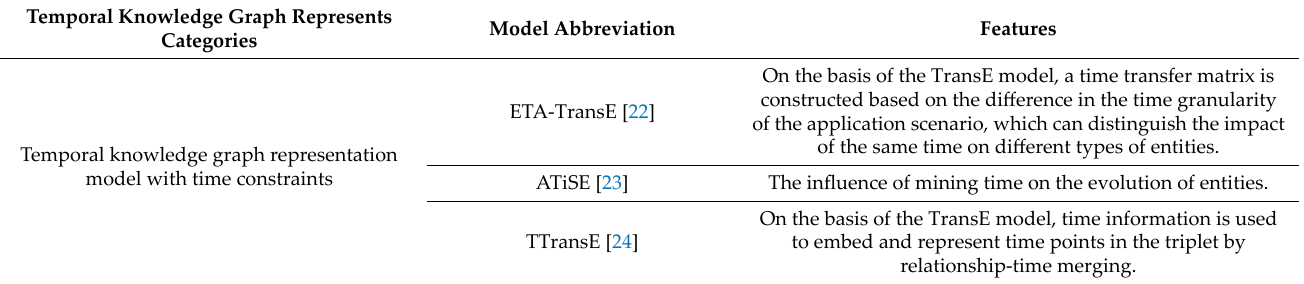
Table 1. Classification of known temporal knowledge construction